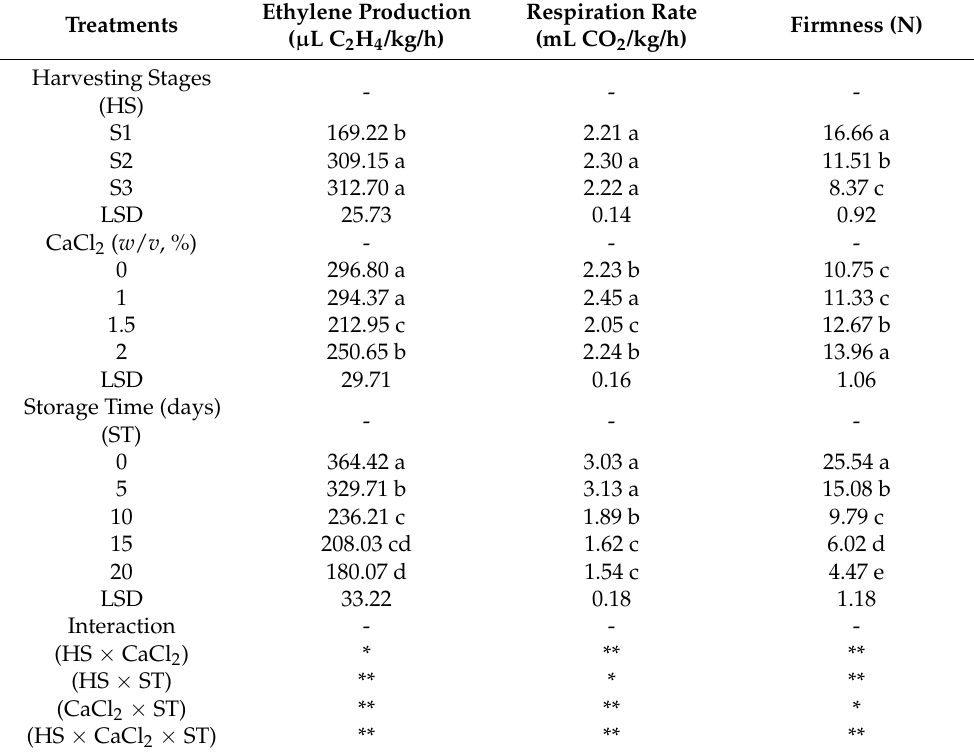
Table 1. Main and interaction effects of harvesting stages (Mature green S1, Breaker S2, and Half ripe S3), concentrations of CaCl 2 (0, 1%, 1.5% and 2, w / v ), and storage time (5, 10, 15, and 20 days) on ethylene production, respiration rate, and fruit firmness stored at ambient temperature (28 ± 2 ◦ C and 75 ± 5%